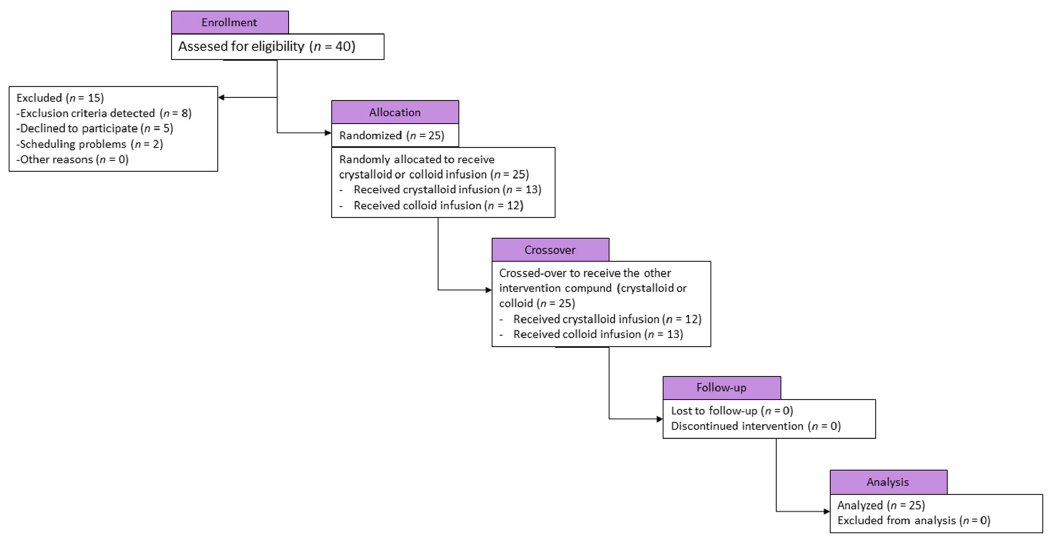
Figure 1. Study flow chart.